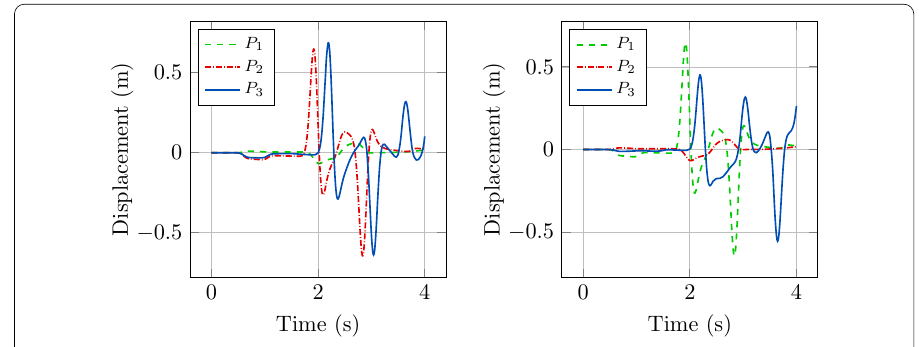
Fig. 4 Time evolution of the displacement field in a homogeneous isotropic medium in three locations (see Fig. 3 for locations). Left: x direction. Right: y direction